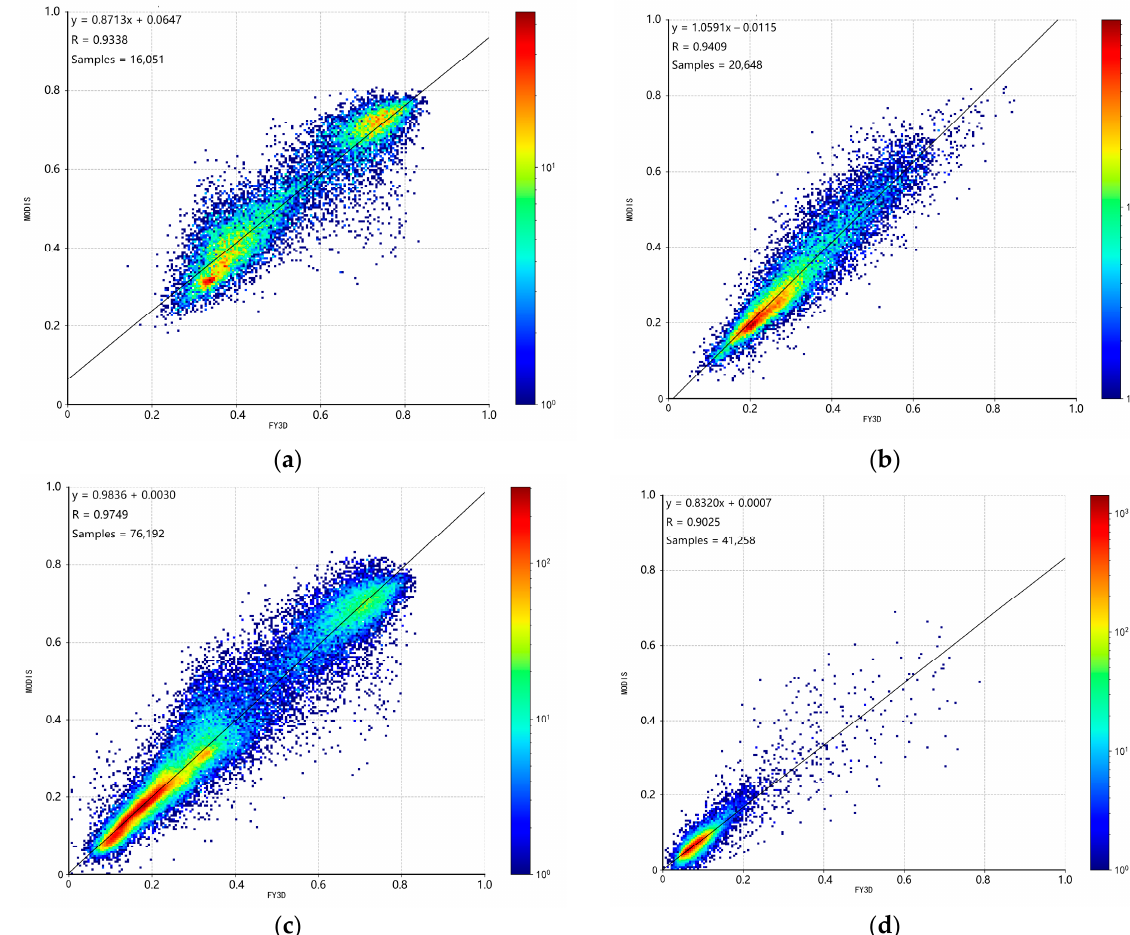
Figure 5. Density scatter plots of FNDVI versus MNDVI for different vegetation types: ( a ) forest NDVI, ( b ) agriculture NDVI, ( c ) grassland NDVI, ( d ) desert NDVI.